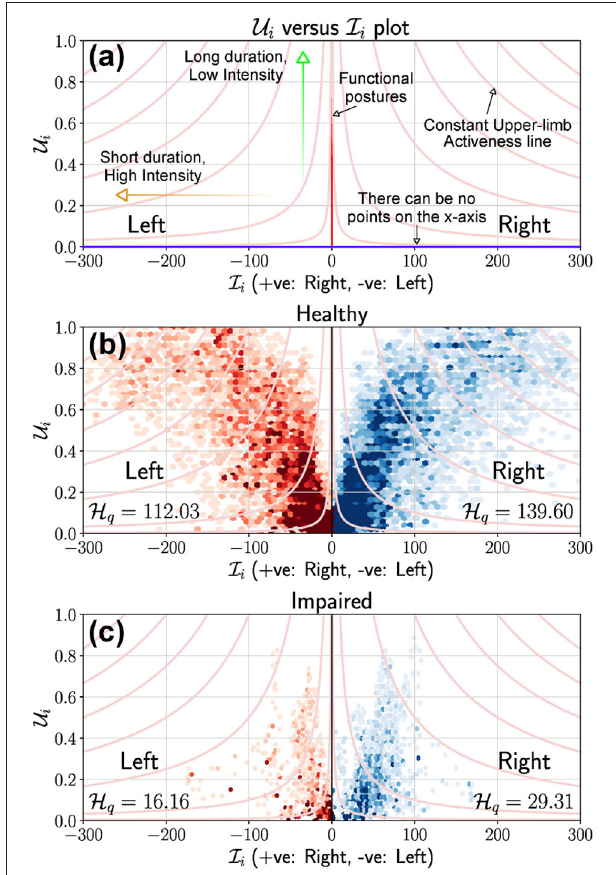
FIGURE 4 | Use vs. Intensity (UI) plot to depict the overall amount of use of the upper-limbs. (a) This plot provides the details of a typical UI plot and highlights some critical elements to help interpretation. The x axis cannot be part of the plot, and light red colored curves are the constant upper-limb activity lines. If f µ is the magnitude of acceleration as is the case in (b,c) , then the y axis represents meaningful/functional postures where the intensity can be zero. (b) UI plot for a healthy participant using data collected from a single day. The 1st and 2nd quadrants of the scatter plot depicts the right (blue) and left (red) upper-limbs, respectively. (c) UI plot for a stroke participant using data collected from a single day. It is clear that the stroke participant has a low level of activity compared to the healthy participant, which is also reflected in their corresponding H q